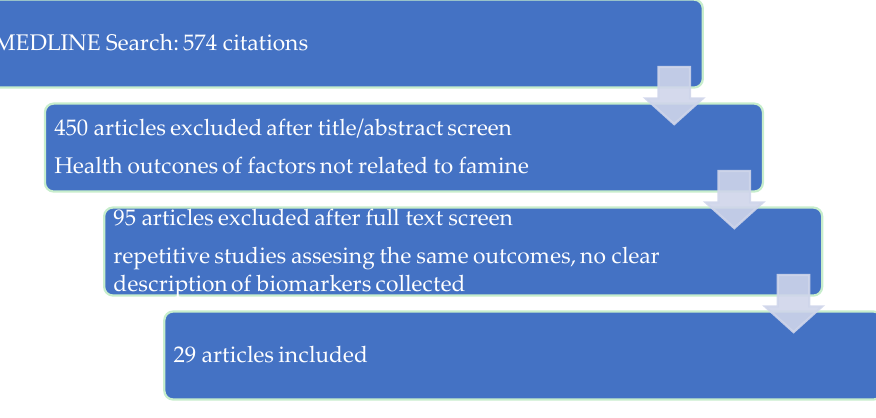
Figure 3. Selection process of eligible studies.